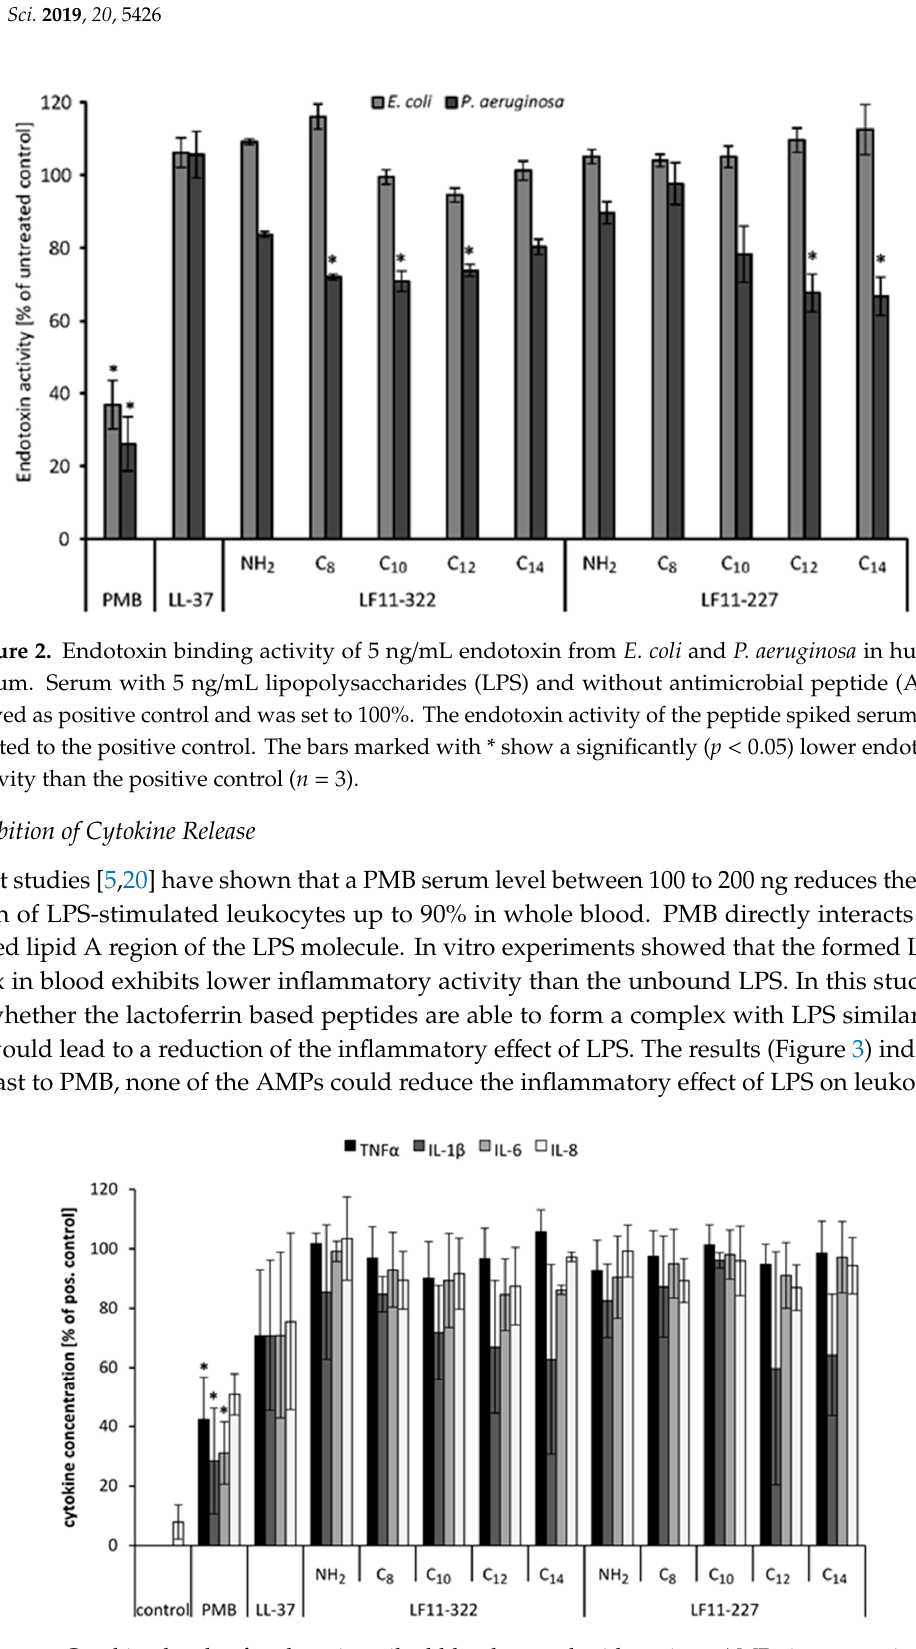
Figure 3. Cytokine levels of endotoxin-spiked blood treated with various AMPs in comparison to the untreated control. Blood without additives served as negative control and blood only with LPS served as positive control. The cytokine level of the positive control was set to 100% and the cytokine concentrations of the samples were compared. The bars marked with * show a significantly ( p < 0.05) lower cytokine level than the positive control ( n =